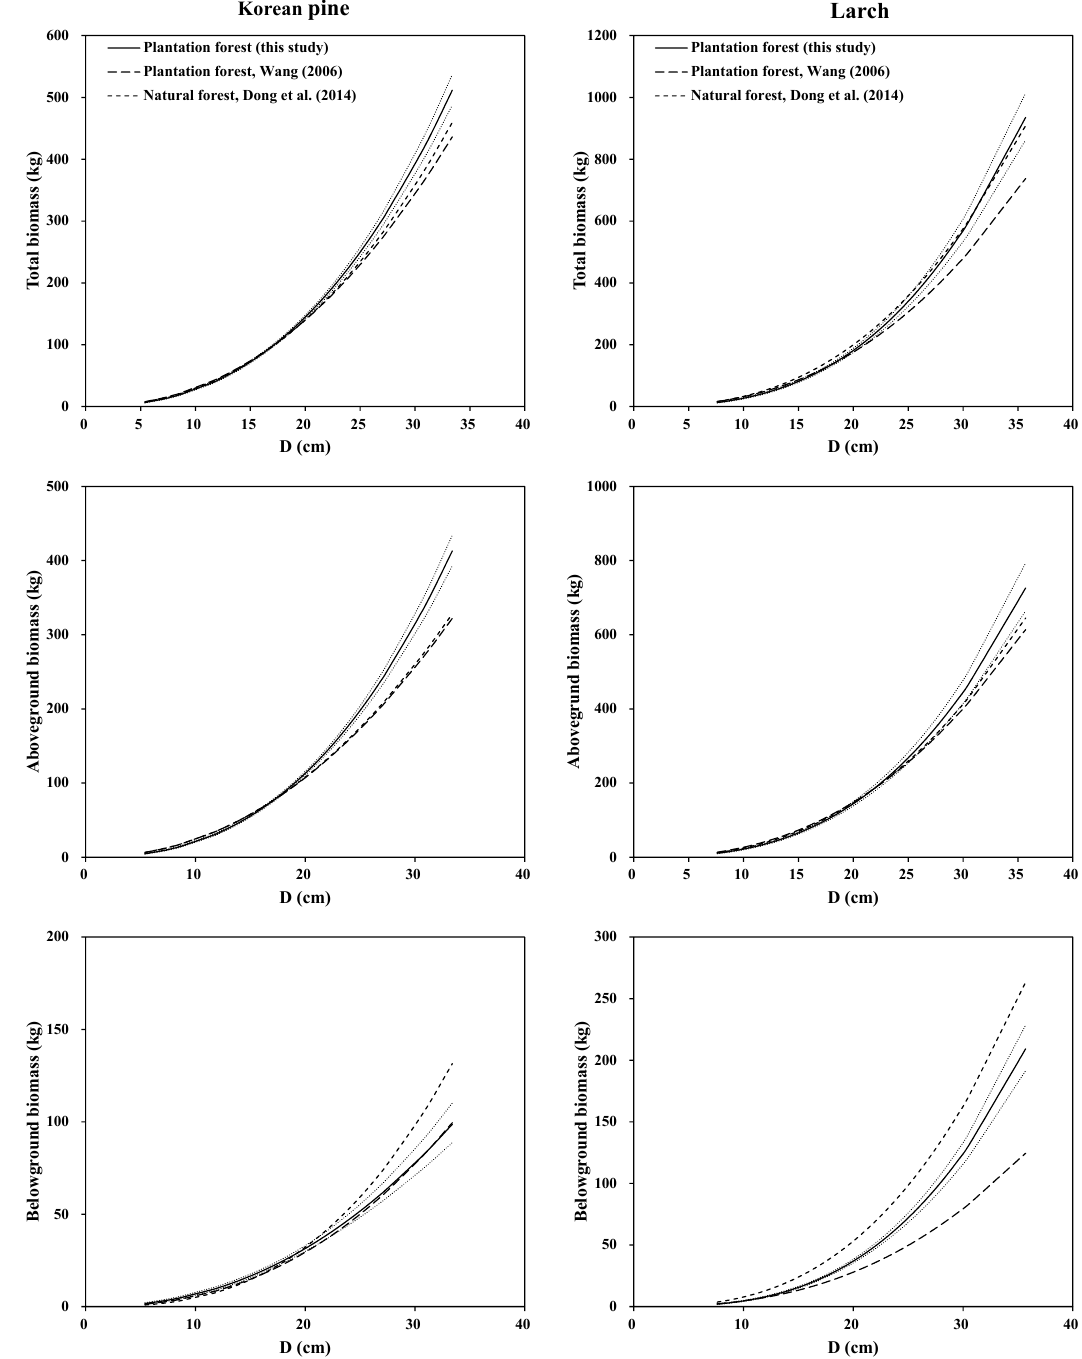
Figure 4. The comparison of model predictions from System 1 in this study, with Wang [11]’s and Dong et al. [33]’s biomass equations for total, aboveground, and root biomass for Korean pine and larch.